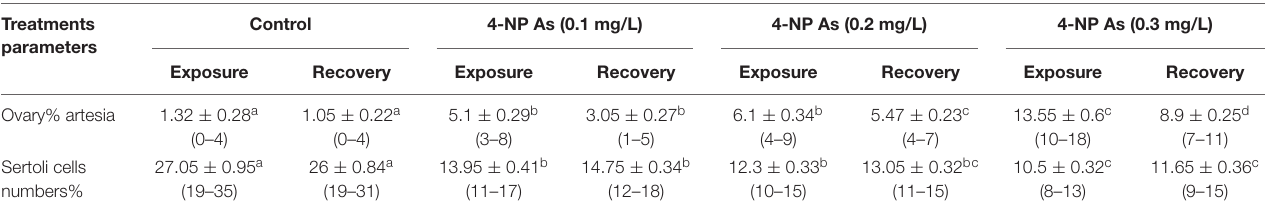
TABLE 3 | Quantitative histological analysis of ovary Artesia and Sertoli cells numbers [mean ± SE (range)] in juvenile African catfish ( C. gariepinus ) exposed to 0.1, 0.2, and 0.3 mg/L4-NP for 15 days and recovery for 15 days. Treatments Control parameters Exposure Recovery Exposure Recovery Exposure Recovery Exposure Recovery Ovary% artesia